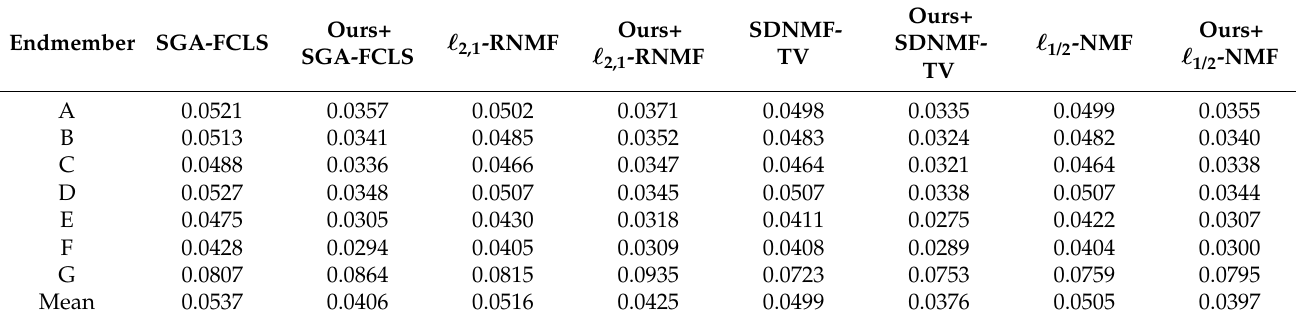
Table 3. Comparison of the SAD result on the real